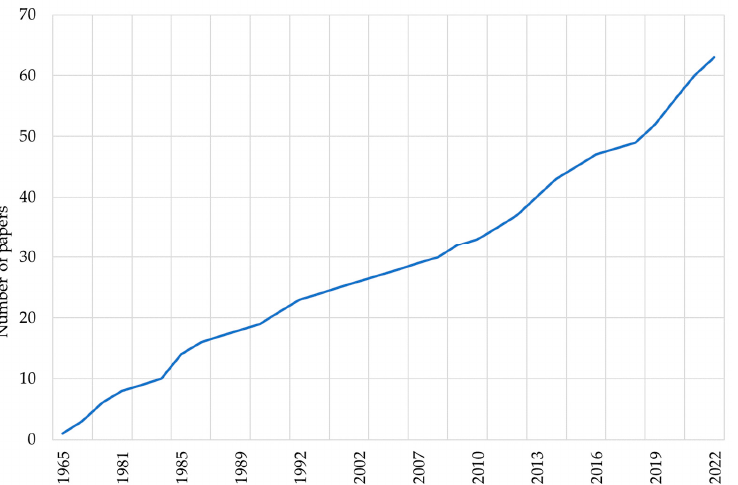
Figure 1. The number of papers published in the years 1965–2022 for the key words “fuel oil combustion modifier”, authors’ report based on https://www.elsevier.com/pl-pl/solutions/scopus (accessed on 27 October 2022).